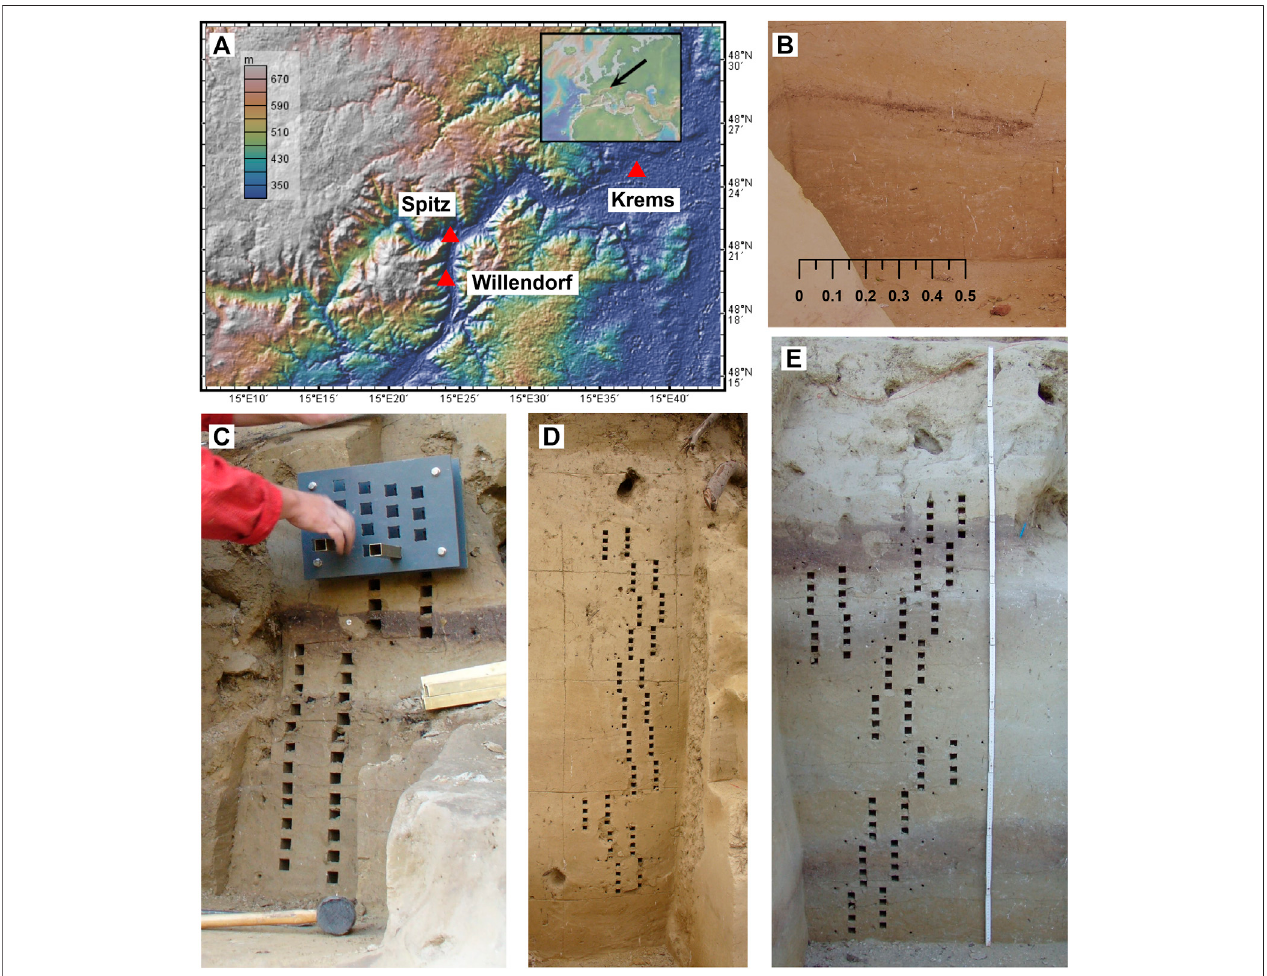
FIGURE 1 | Location of the Willendorf Site in Lower Austria [ (A) ; top] in the vicinity of the cities Spitz and Krems, and fi eld photos of sediment movement (B) , including a scale of 0.5 m, (C) the right pro fi le #5, (D) the left pro fi le #4, and (E) pro fi le #1. Note that images (B – D) were taken into the wall, where (E) is taken perpendicular to the wall. Photographs were taken in daylight and partly under a tent, therefore illumination is imperfect.